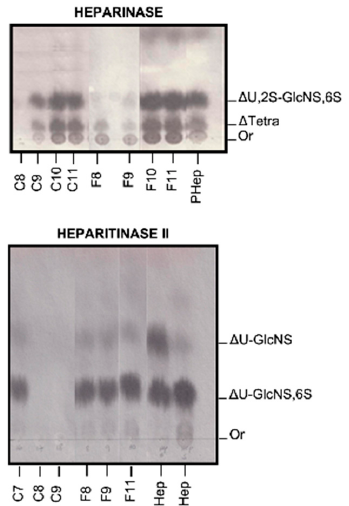
Figure 3. Analysis of heparinase and heparitinase II products from crude and final heparin samples. Crude and final heparin samples were incubated with heparinase and heparitinase II and the degradation products